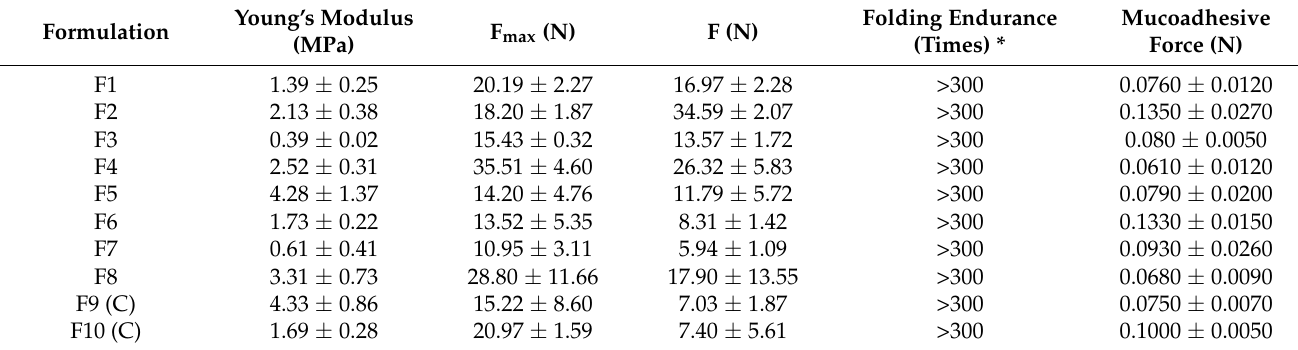
Mechanical and mucoadhesive properties of film formulations composed of polyvinyl alcohol (PVA), polyvinylpyrrolidone (PVP), ethylcellulose (EC) and tramadol (10%, w / w ). The results represent the mean ( ± standard deviation) of at least three of the replicate samples